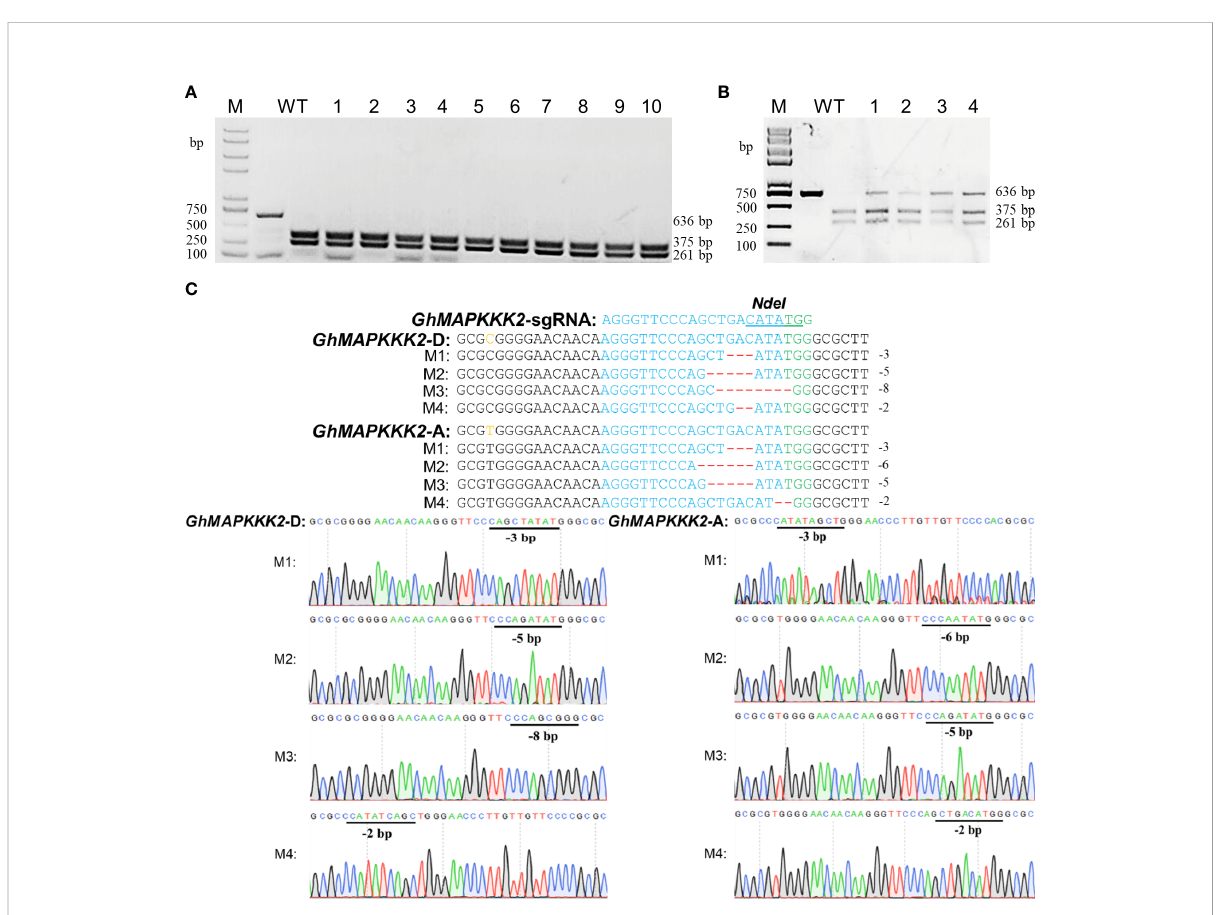
FIGURE 2 Detection of gene editing effects in two transient transformation modes. (A) Detection of AtU6-26:: GhMAPKKK2 -sgRNA-Cas9-p1300 targeted mutations. Wild-type served as a control, and 1-10 were plant numbers. The gel image shows PCR products of the GhMAPKKK2 gene and digested PCR products with Nde I. (B, C) Detection of CLCrV-AtU6-26:: GhMAPKKK2 -sgRNA targeted mutations. (B) Wild-type served as a control, and 1-4 were plant numbers. The gel image shows PCR products of the GhMAPKKK2 gene and digested PCR products with Nde I. (C) The undigested PCR products lacking the Nde I site (due to the presence of a mutation) that were subsequently puri fi ed, cloned, and analyzed by sequencing. The green color indicates the PAM sequence. The Nde I restriction site on the target sequence is underlined in blue. M indicates the mutation sequence. Deletions are shown as red